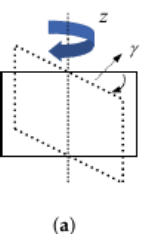
Figure 1. RIS-aided indoor MISO-VLC system. RIS in this scene contains N x × N z identical rectangular mirrors, and the size of each element is δ ( m × m ) . The center point of each mirror is located in a plane perpendicular to the y axis. Each mirror’s direction can be rotated on one’s own, and we define the angle which rotates clockwise in the positive direction of the x axis as roll angle ω and yaw angle γ to the z axis, as shown in Figure 2.